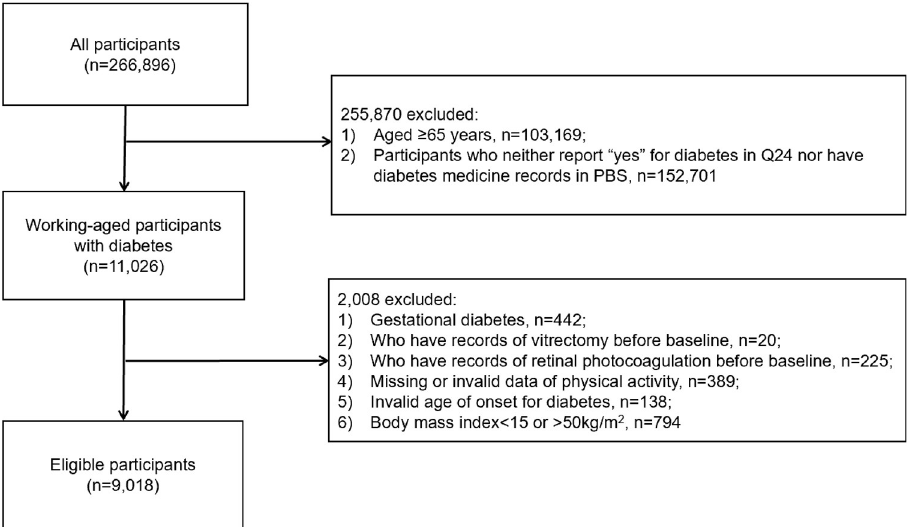
Fig 1. Algorithm for identifying eligible